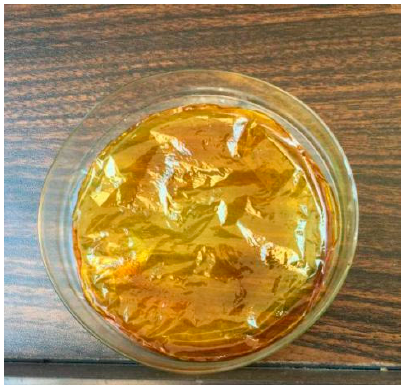
Figure 5. Optimized sensitive membrane (scale bar = 1:2).